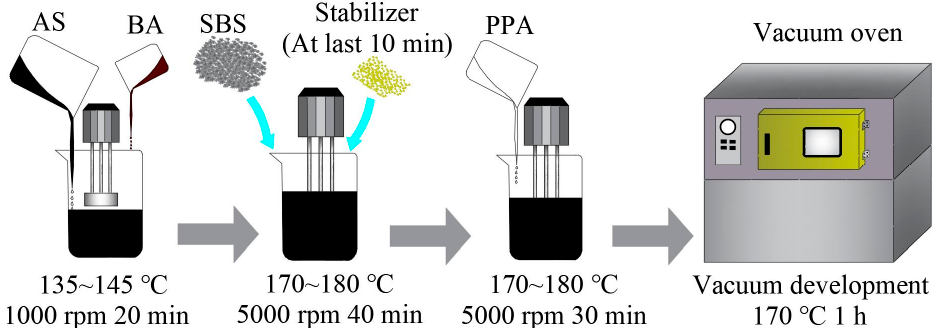
Figure 1. Preparation process of BA/PPA/SBS-modified asphalt.